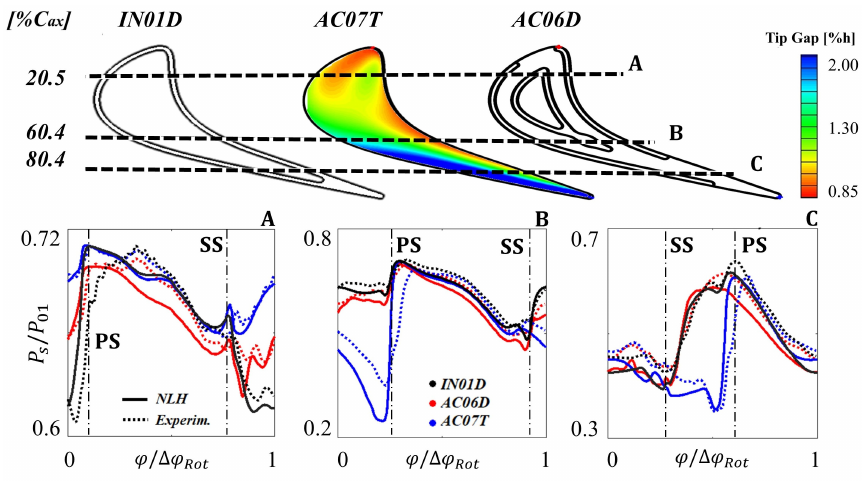
Figure 3. Time-resolved casing static pressure over a rotor blade pitch: numerical and experimental